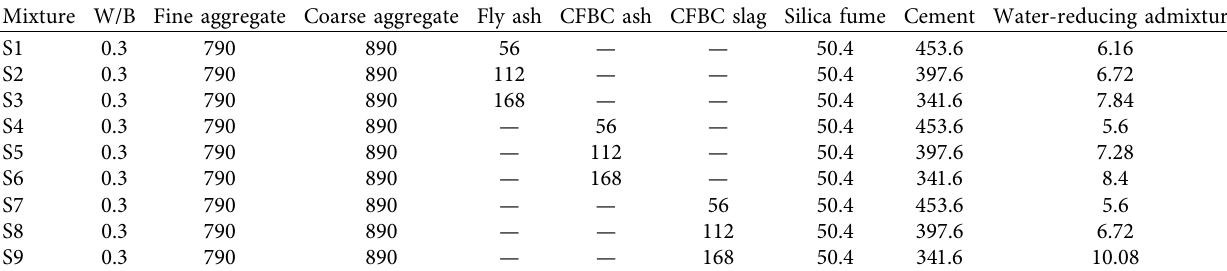
Table 4: Mixture proportions of HPC (kg/m 3